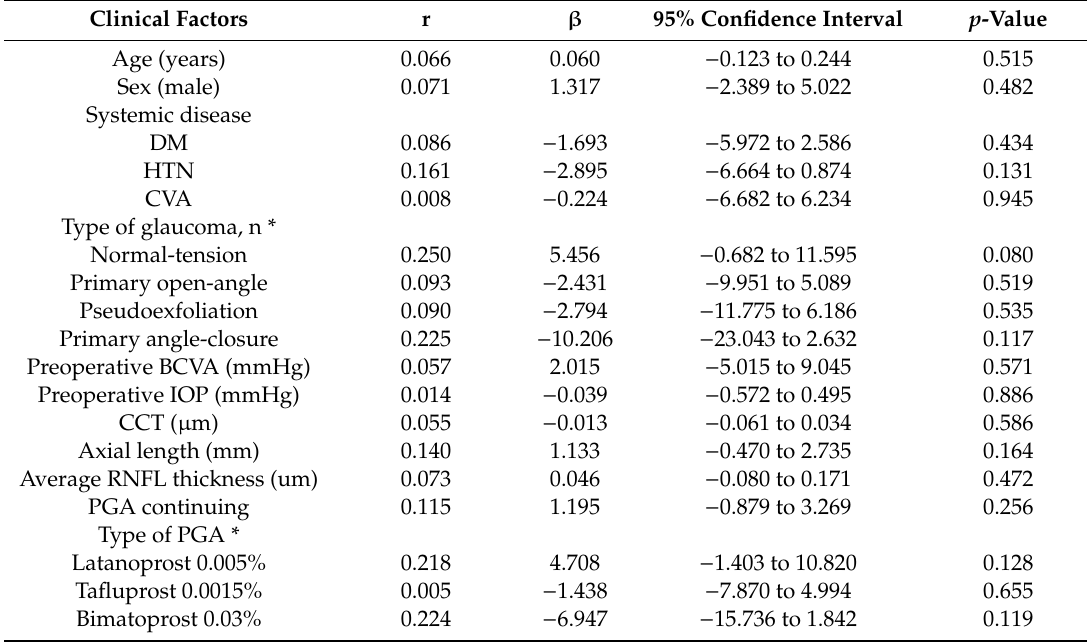
Table 5. Clinical factors associated with postoperative central macular thickness ( µ m)